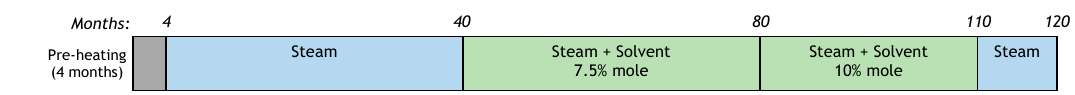
Figure 17. Combination of cycle’s duration and mole fraction that led to the same amount of oil production with a lower cEOR.